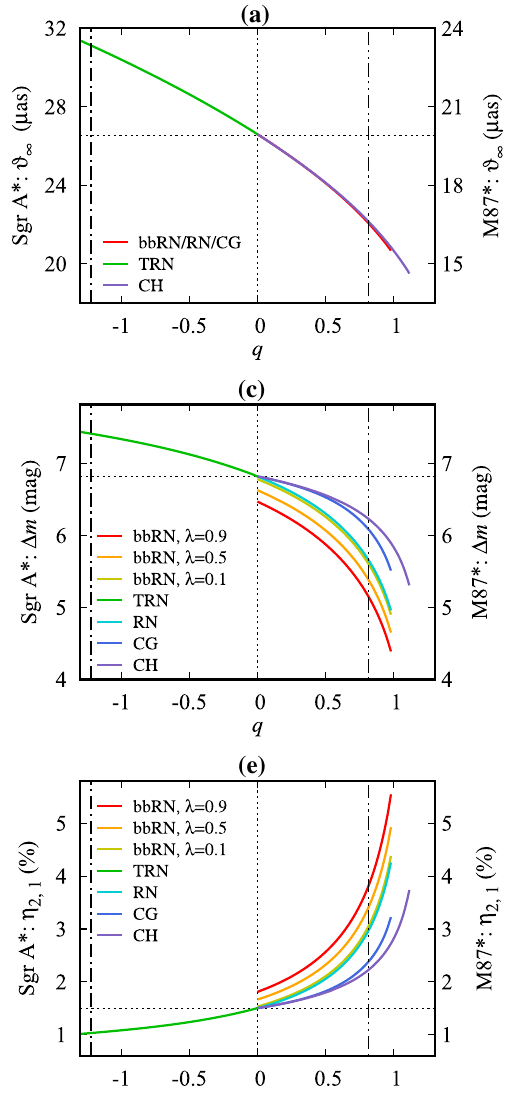
black hole (CG). The left and right dash-dotted lines mark the lower and upper bound on q based on the shadow of M87* observed by EHT, see Eqs. (10) and (11). The horizontal dotted lines denote those values for the Schwarzschild black hole